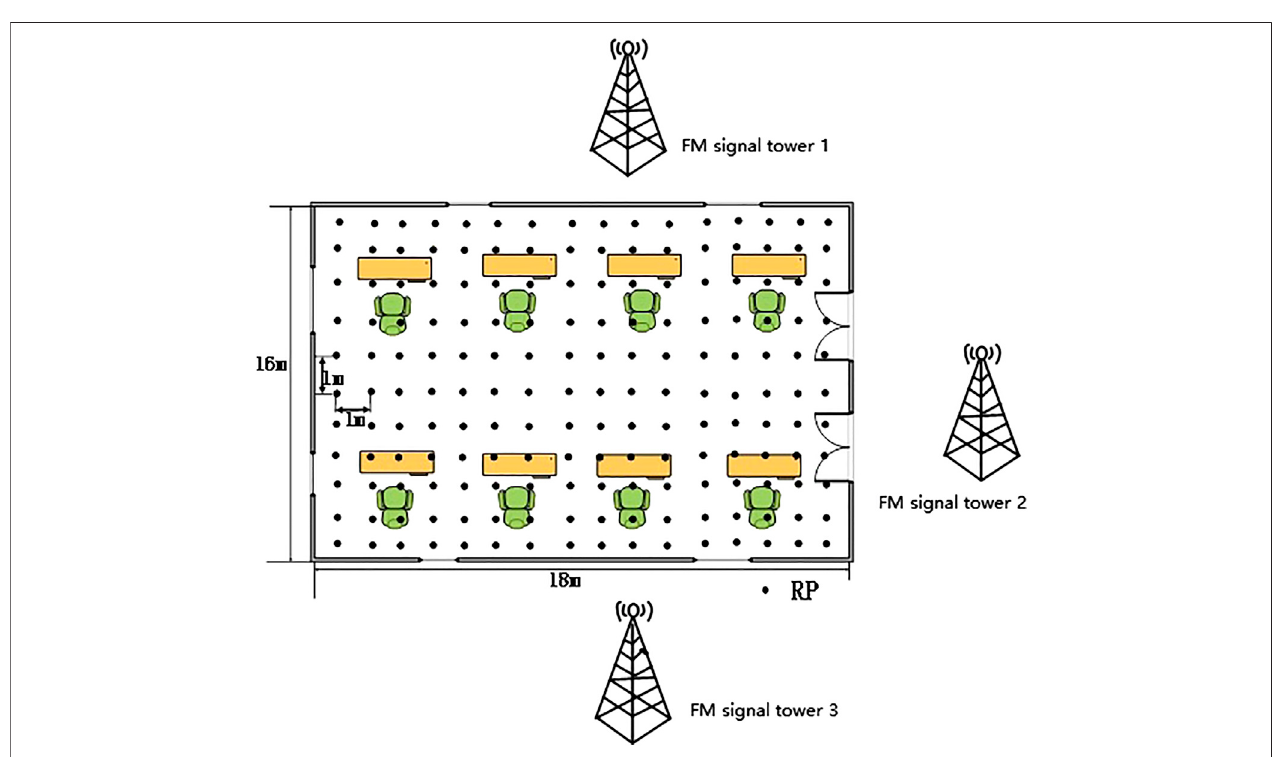
FIGURE 3 | Room 308 was 18 m in length and 16 m in width. Each RP was set in every meter